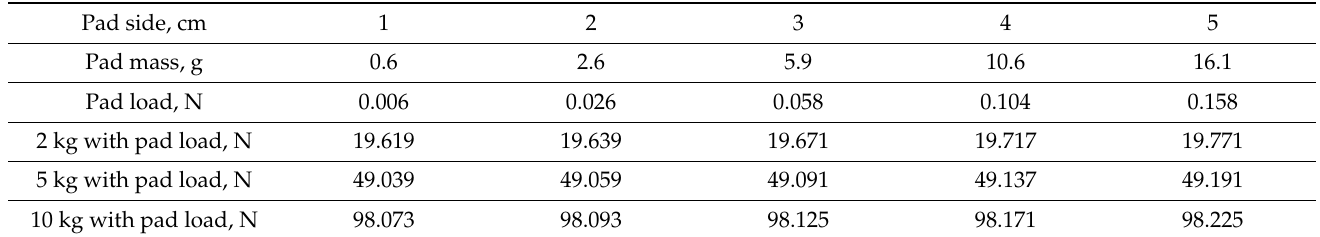
Table 1. Parameters of facilities used in dead weight calibration.